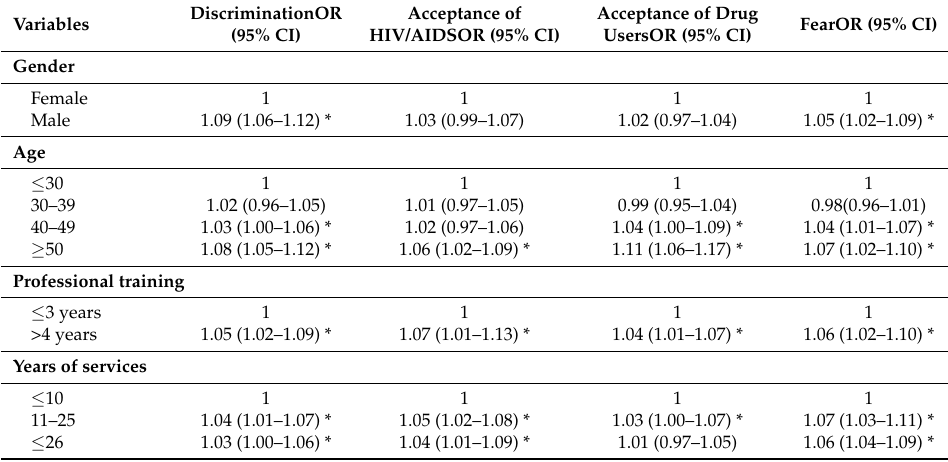
Table 3. Logistic